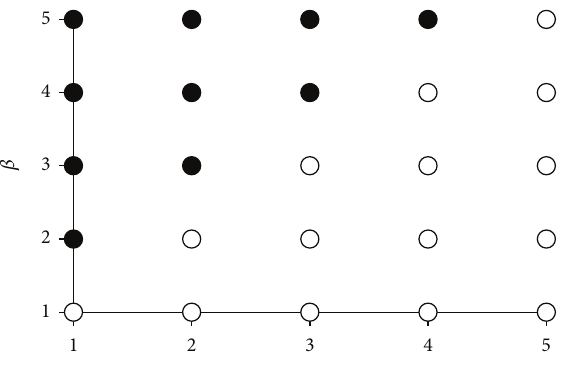
Figure 2: Selection of CF-function weights. Dark circles represent elutions with well separated peaks (all 𝑅 𝑆 ≥ 3 ) in acceptable analysis time (maximal 30min) and the white ones are those with at least one overlapped peak pair ( 𝑅 𝑆 < 3 ) or with exceeded analysis time.